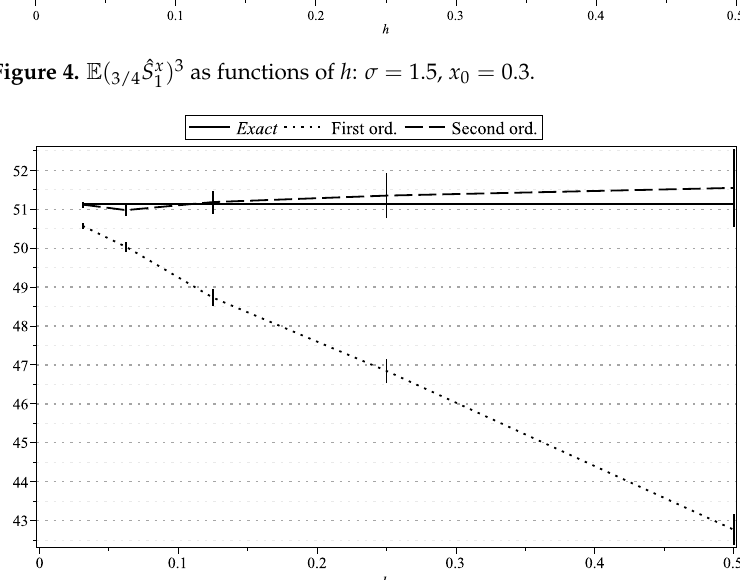
) 4 as functions of h : σ = 0.8, x 1